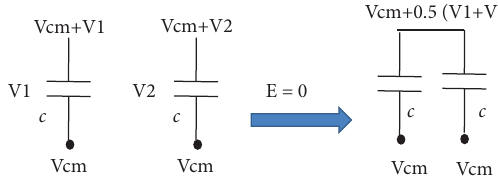
Figure 29: Zero energy drained from Vcm